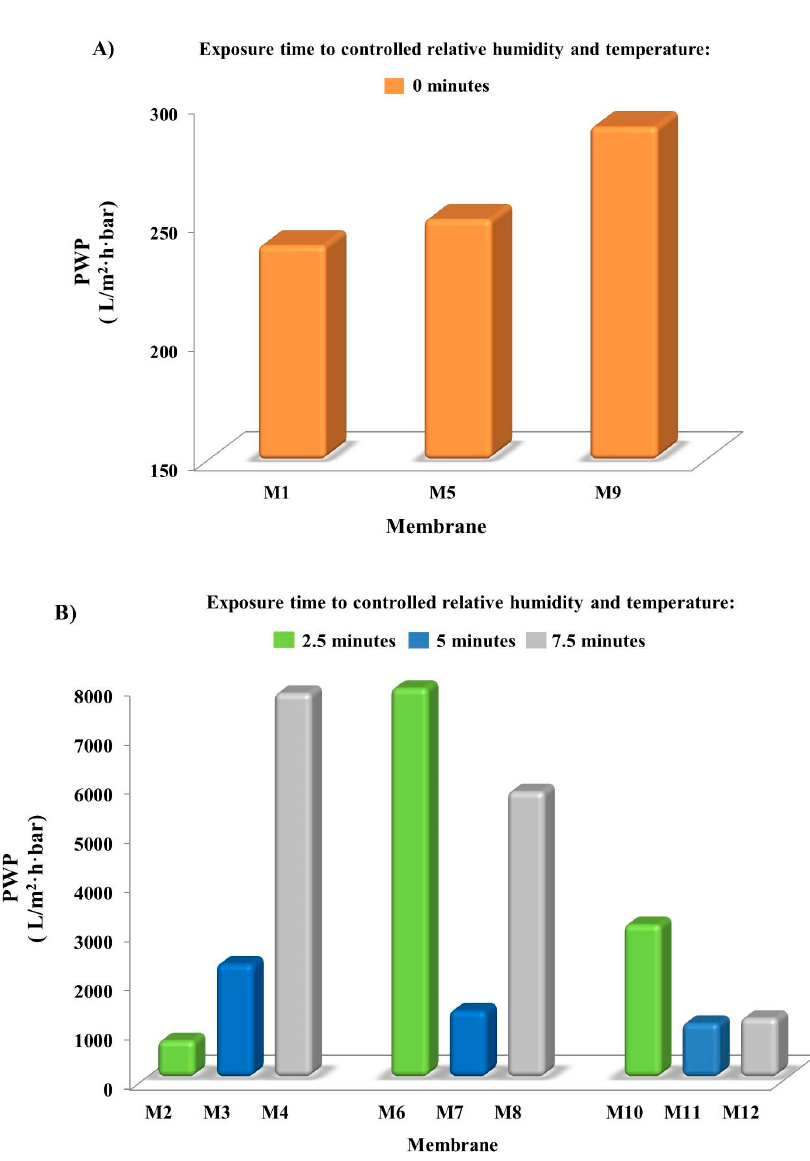
Figure 4. PWP of the membranes prepared via: ( A ) NIPS; ( B ) VIPS-NIPS (in all cases, the relative standard error was less than 5%).